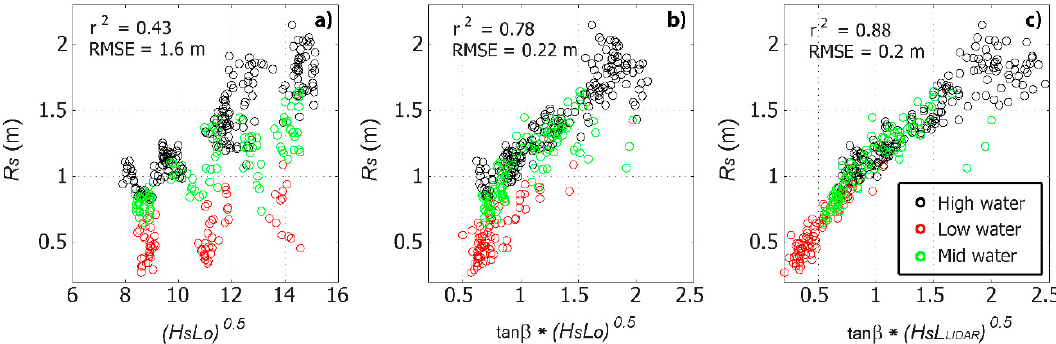
Figure 7. Scatter plots of the significant vertical run-up (R s ) as a function of (H s L o ) 0.5 ( a ), tan β (H s L o ) 0.5 ( b ), and tan β (H sLIDAR L o ) 0.5 ( c ). The red, black and green colors are related to the low, high and mid tide levels respectively.